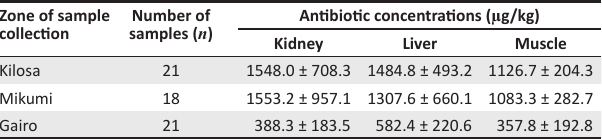
TABLE 1: Oxytetracycline concentration in cattle tissue from the Kilosa district, Tanzania. Zone of sample Number of collection samples ( n